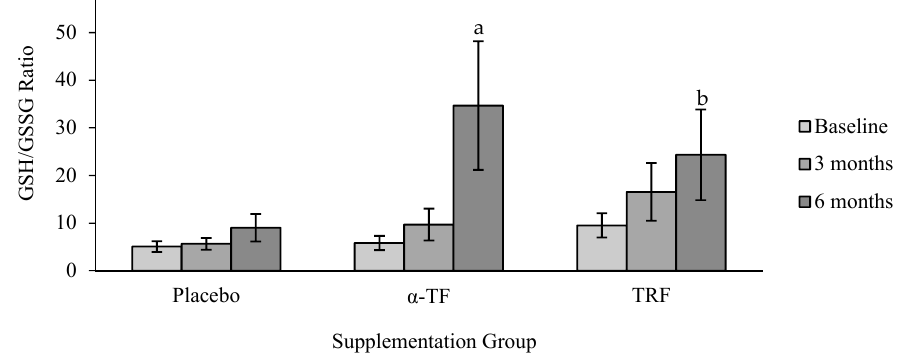
Figure 11. Effect of α -TF and TRF supplementation on GSH/GSSG ratio for 6 months. a = significantly